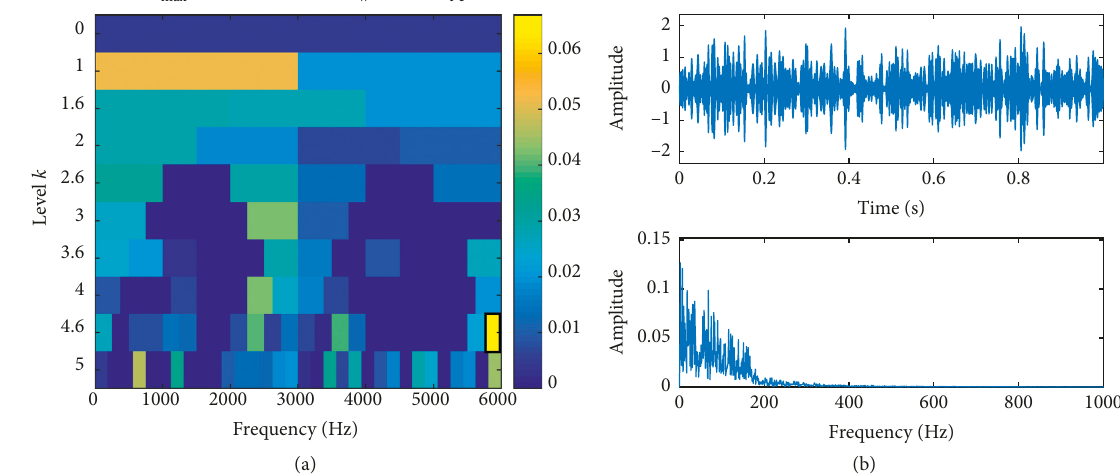
Figure 7: (a) Fast kurtogram based on FIR; (b) signal component and its envelope